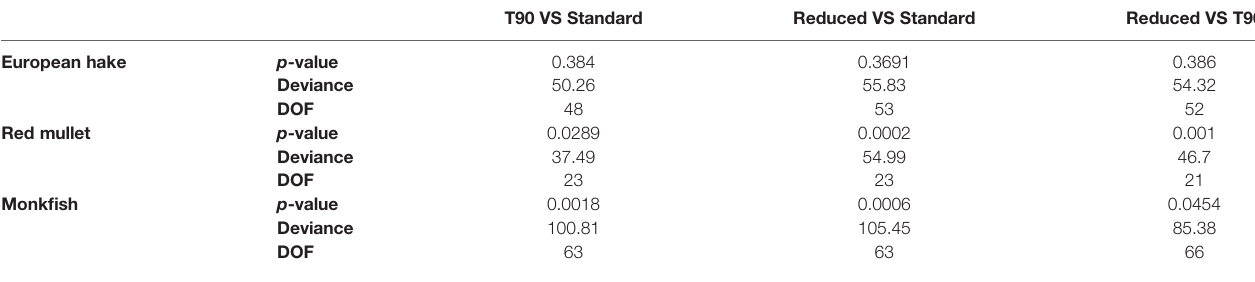
TABLE 4 | Fit statistics of the combined model used in the three catch comparisons (T90 VS Standard, Reduced VS Standard, Reduced VS T90). T90 VS Standard